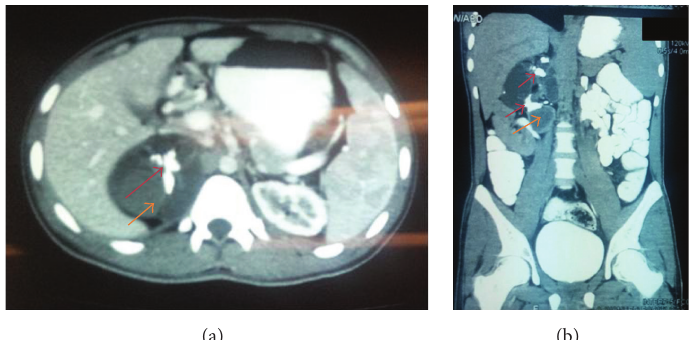
Figure 1: Contrast enhanced CT scan showing cystic mass with solid component (marked with orange arrow) and areas of calcification (marked with red arrow). (a) Axial section. (b) Coronal section.